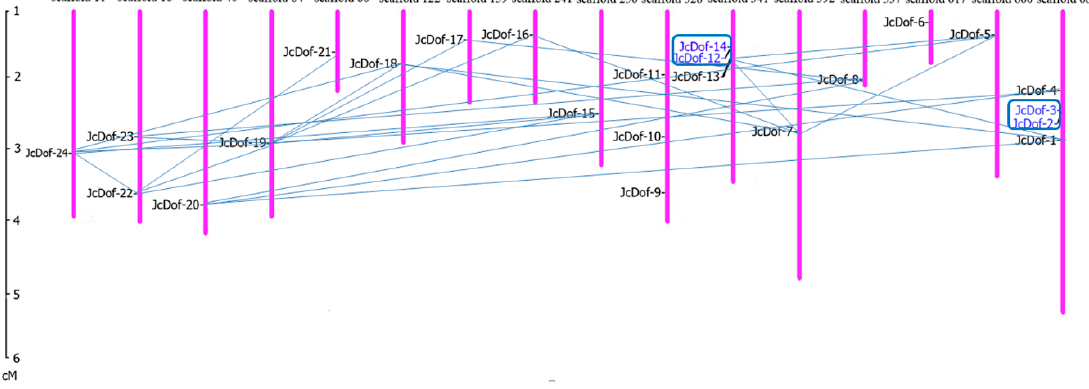
Figure 5. The Ka / Ks value of duplicated JcDof gene pairs. 28 pairs of duplicated JcDof genes and 23 pairs duplicated genes with Ka / Ks more than one. The detailed Ka / Ks information of duplication pairs are described in Supplementary Table S5 . 2.6. Expression Patterns of JcDof Genesunder Different Abiotic Stress and Hormone Treatments In order to further study the possible function divergence of JcDof genes, we investigated the expression level of JcDof genes under various abiotic stresses and hormonal treatments by using the public transcriptome data from NCBI SRA database (Supplementary Tables S6 and S7 for detailed information). We employed a heatmap to visualize a global transcription profile of the JcDof genes. As shown in Figure 6, JcDof genes showed diverse responses to various treatments, and significant differences were found in response to 6-Benzylaminopurine (BA), salt, and drought treatments (two- fold increases or decreases compared to controls).